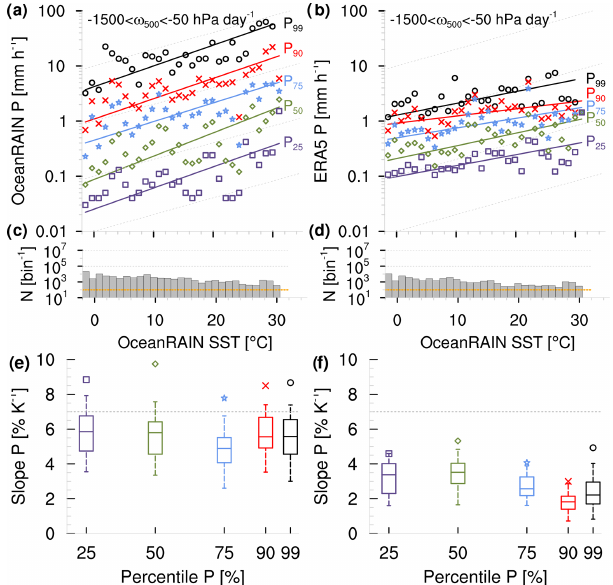
Figure 5. As Fig. 2 but for all OceanRAIN–ERA5-matched time steps for OceanRAIN (a, c, e) and for ERA5 (b, d, f) , both for rising motion ( − 1500 < ω 500 < − 50hPad − 1 ) and excluding regions of r(P,ω 500 ) > − 0 . 2 from Fig. 3. Orange lines in (c) and (d) mark the lowest N for which P 99 can be calculated.